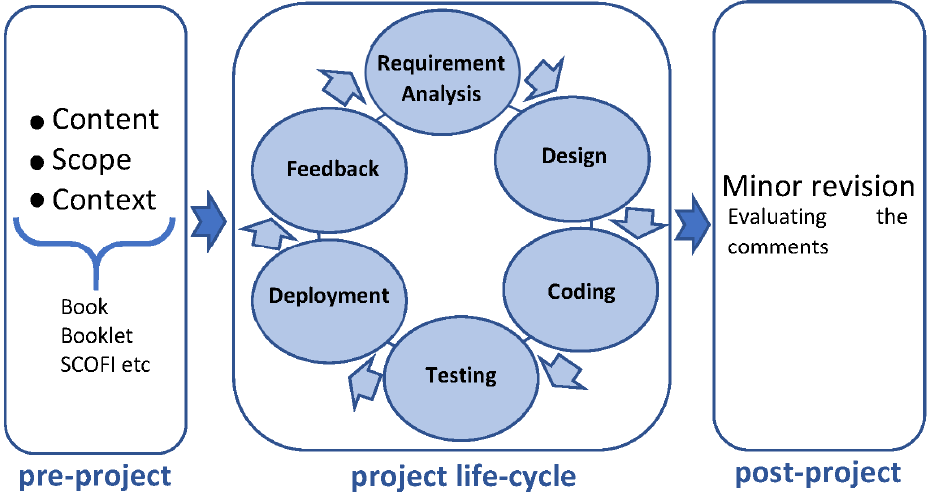
Figure 1. Project Implementation Process.